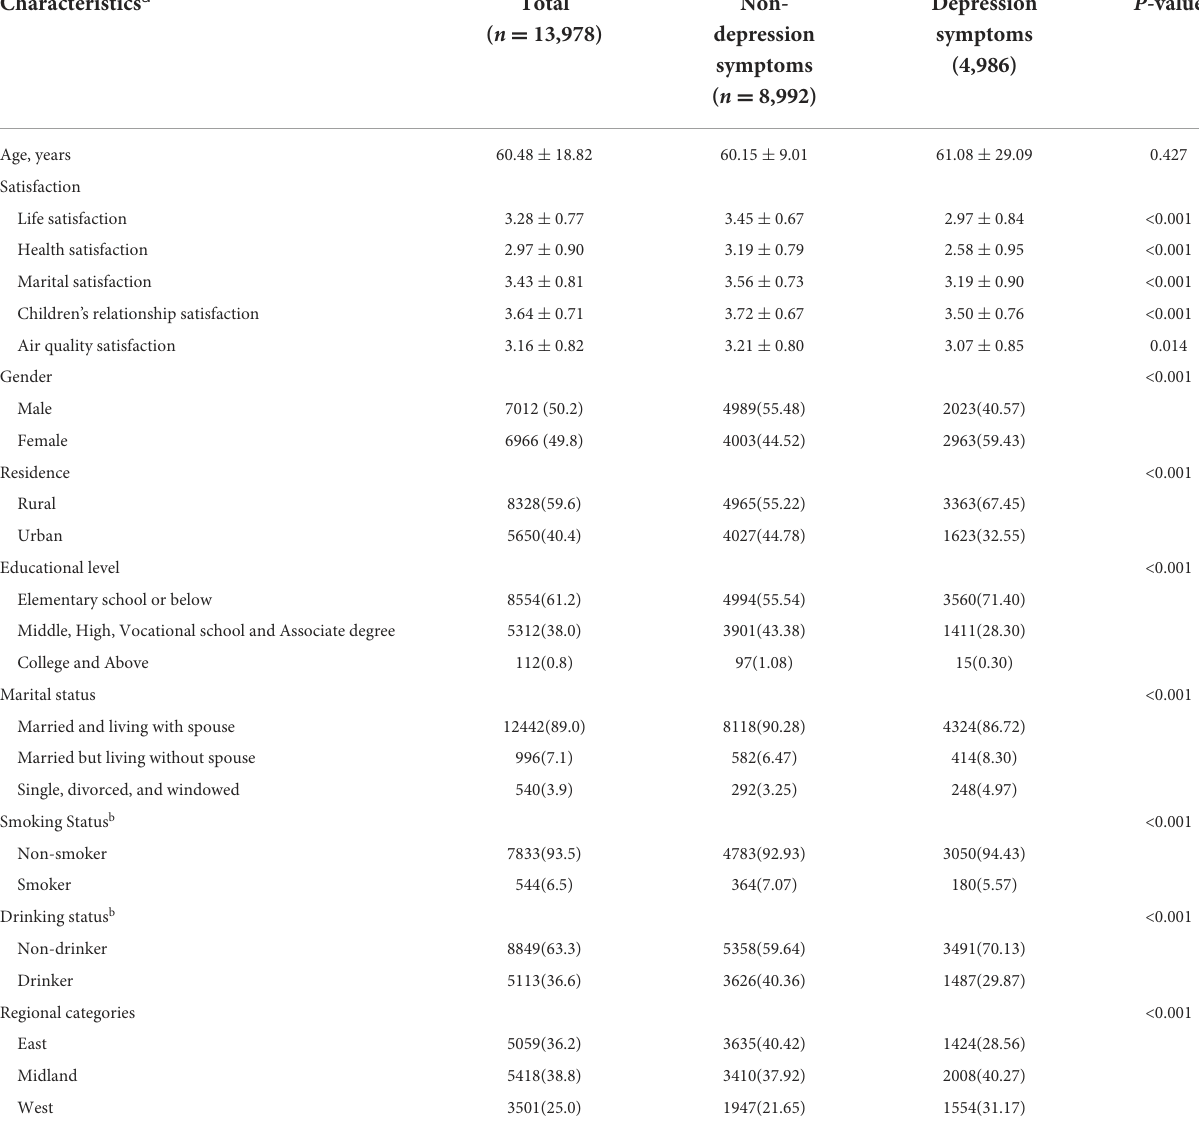
TABLE 1 Basic characteristics of participants in the China Health and Retirement Longitudinal Study (CHARLS) wave 4. Characteristics